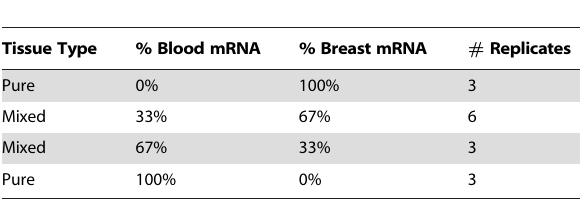
Table 1. Experimental design for blood vs . breast microarray